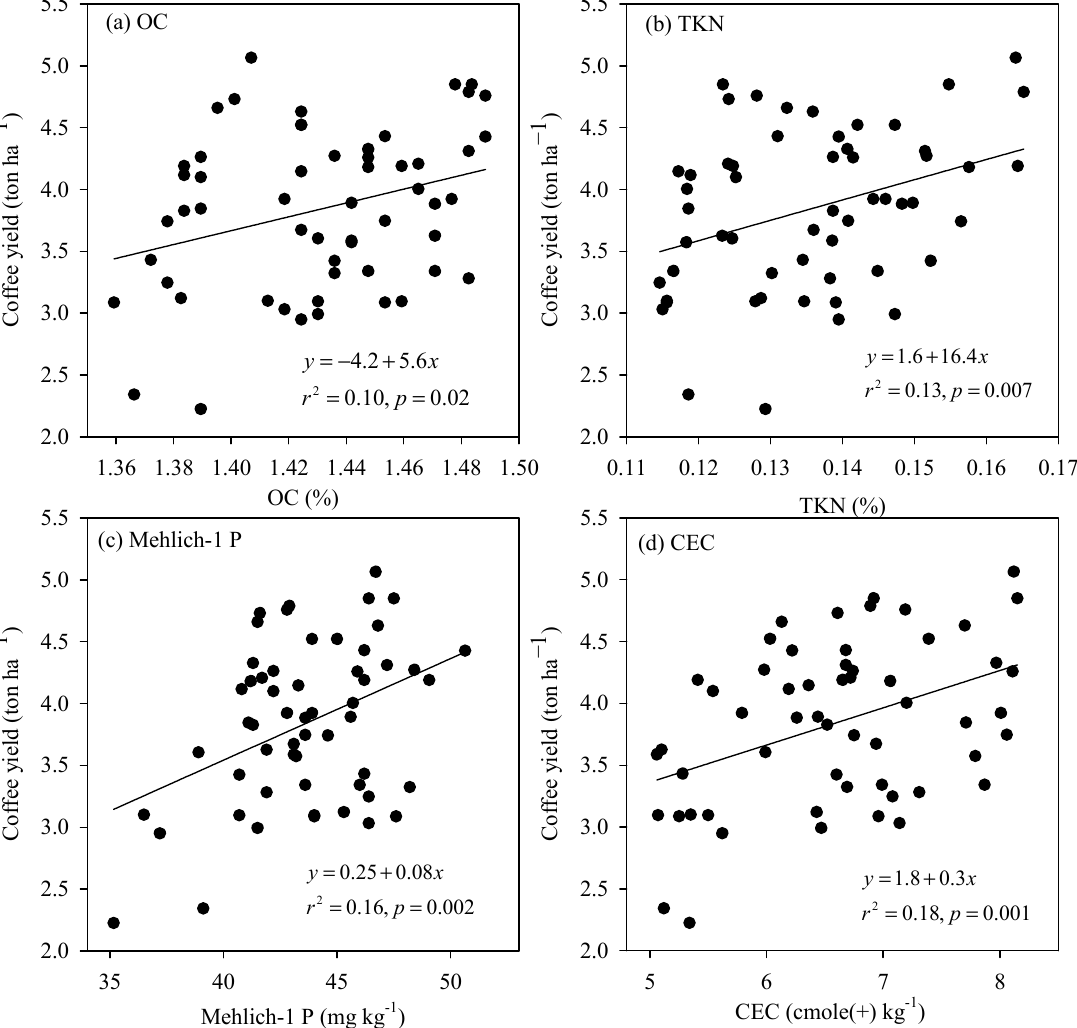
Figure 3. The relationship between coffee yield and ( a ) OC, ( b ) TKN (Total Kjeldahl nitrogen), ( c ) Mehlich-1 P, and ( d ) CEC of the SCL soil.